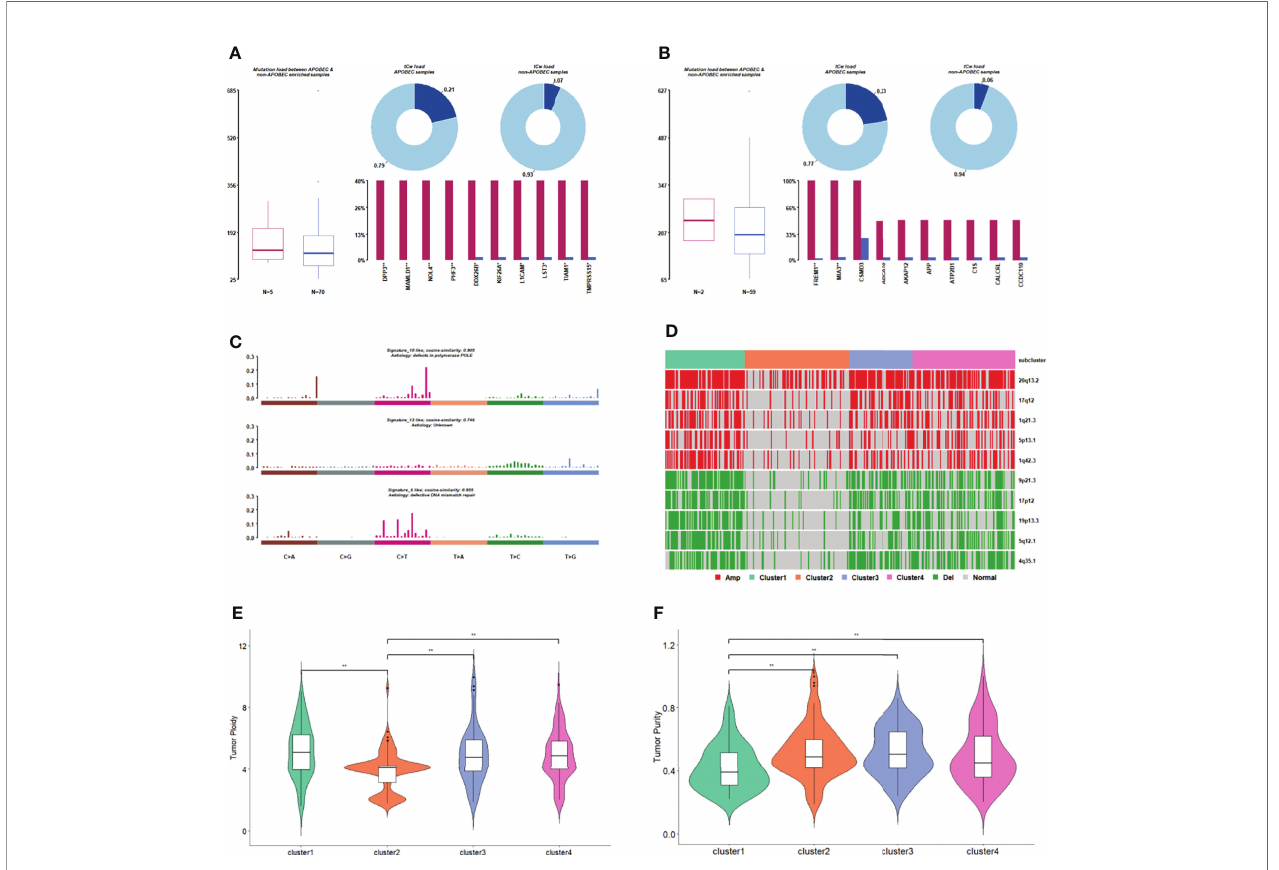
FIGURE 5 | Comparison of gene mutation in subgroups. (A) APOBEC enrichment analysis in cluster 1. (B) APOBEC enrichment analysis in cluster 3. (C) The signature with high degree similarity in cluster 2 and cosmic signature. (D) The distribution of CNV regions with signi fi cant differences in ampli fi ed/deleted regions among subgroups. (E) Tumor ploidy distribution among subgroups. (F) Tumor purity distribution among